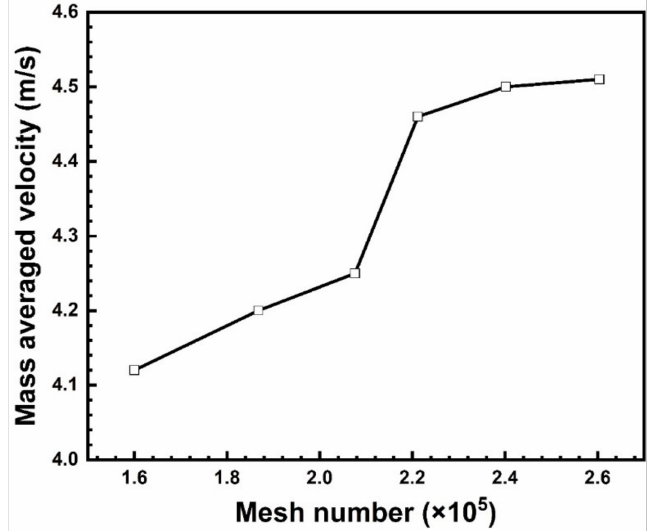
Figure 4. Variation of the mass averaged velocity on wire 0402 with the mesh number. The inlet flow velocity of 5 m/s and outlet pressure of 101,325 Pa were used for the inlet and outlet boundary conditions. A default convergence criterion in the residual